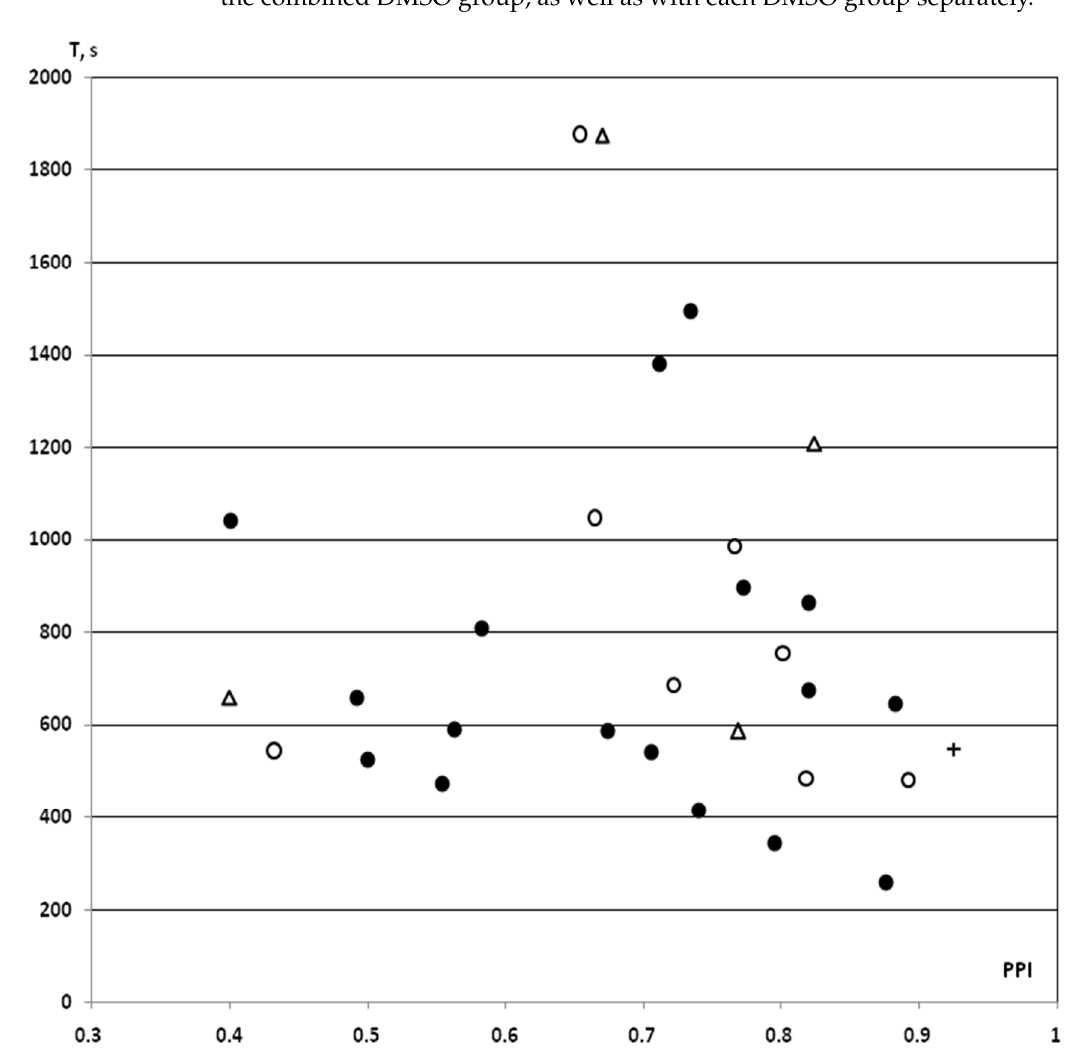
Figure 2. PPI-associated individual values of resistance to hypoxia in control rats with PPI ≥ 40% exposed to SHBH 4 min after the end of the HBH session. HBH, moderate hypobaric hypoxia (hypoxic preconditioning); SHBH, severe hypobaric hypoxia. T (s, ordinate axis), a time until agonal respiration (apnea) under SHBH conditions; PPI (abscissa axis), prepulse inhibition in the acoustic sensorimotor startle reaction model. The PPI values are presented in decimal digits. On the graph, individual values of T corresponding to own PPI values. Dark round markers, the T values of saline IP group obtained in previous experiments (saline + HBH, IP introduction, n = 17); light circles markers, the T values of saline IP group in this study (saline + HBH, IP introduction, n = 8); light triangles markers, the T values of saline iHippo group in this study (saline + HBH, iHippo introduction, n = 4); cross marker, control for surgical procedures, the T value of this study obtained on a rat implanted with cannulas (HBH only, without saline introduction). In the saline IP and iHippo groups, the one value of T in each of them calculated as “outliers” was excluded from the analysis (both T > 1800 s). The T values on the graph represented a same variation series (see also Figure 3). Therefore, the data from this study were combined into a control group with the exception of “outliers” (n = 11, A in Figures 4 and 5).